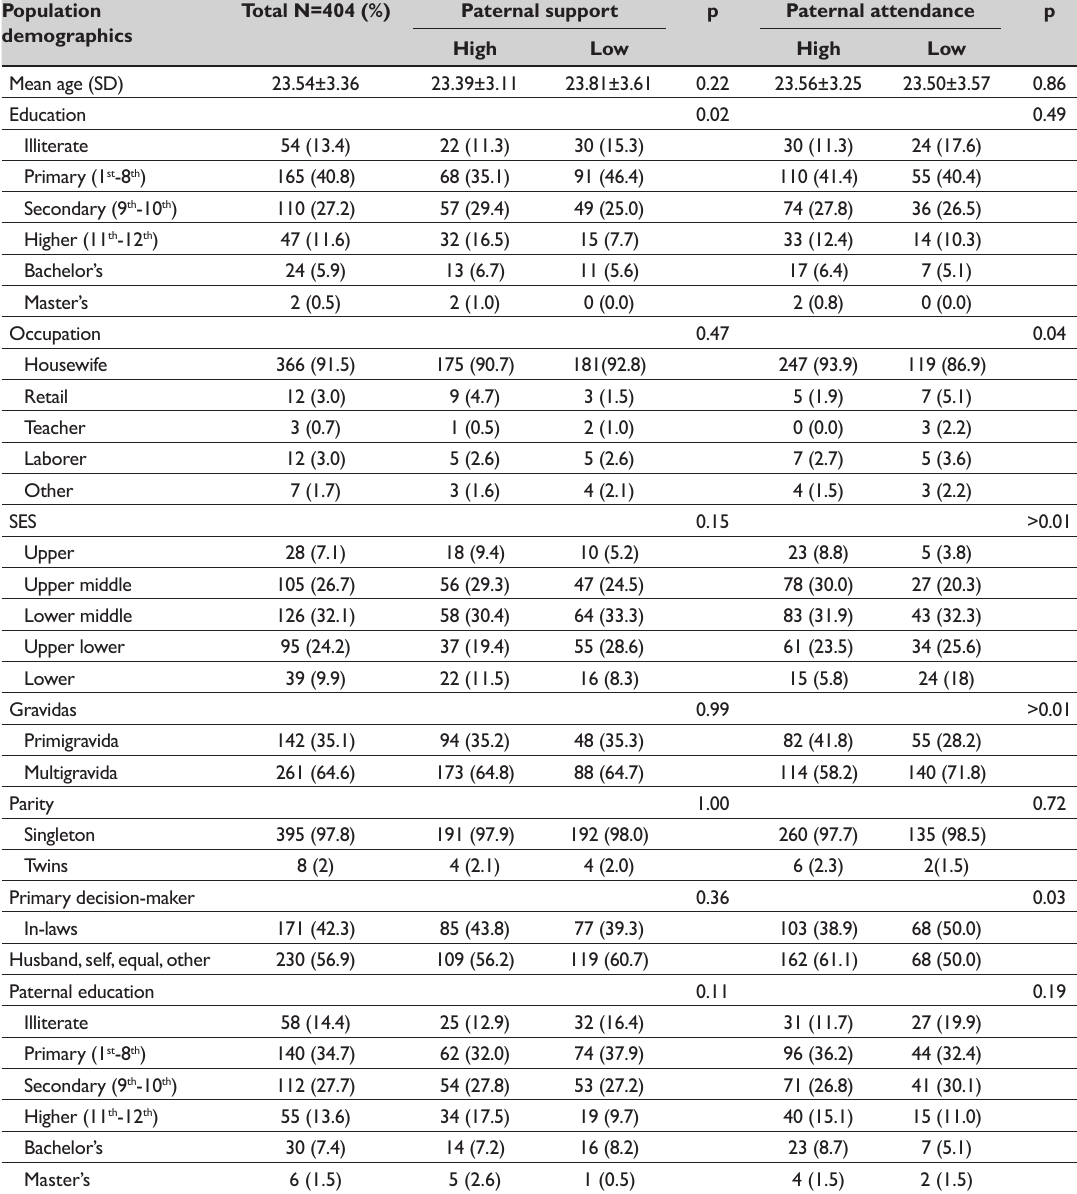
Table 1: Population and paternal demographics by paternal support and attendance Population